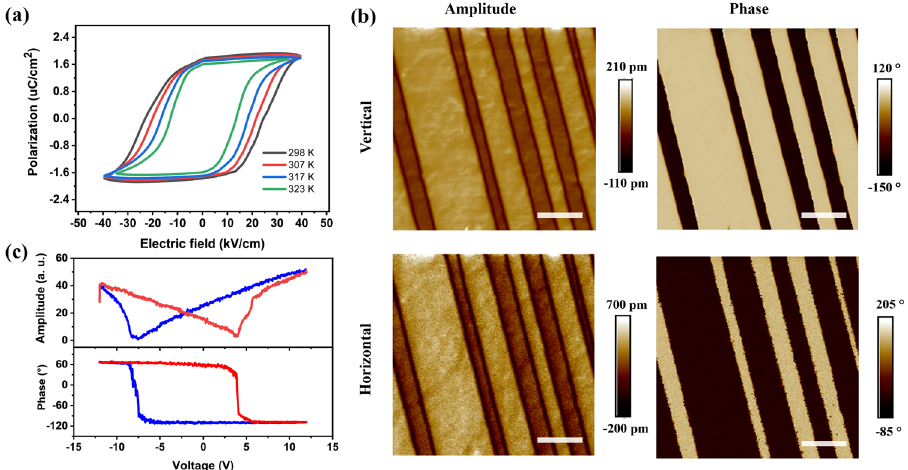
Fig. 2 Ferroelectric hysteresis loops and domain patterns of TSC. a Polarization vs electric fi eld hysteresis loops at different temperature. b Vertical and horizontal PFM amplitude and phase signals. All scale bars are 2 μ m. c Amplitude vs voltage and phase vs voltage curves, displaying local piezoelectric hysteresis